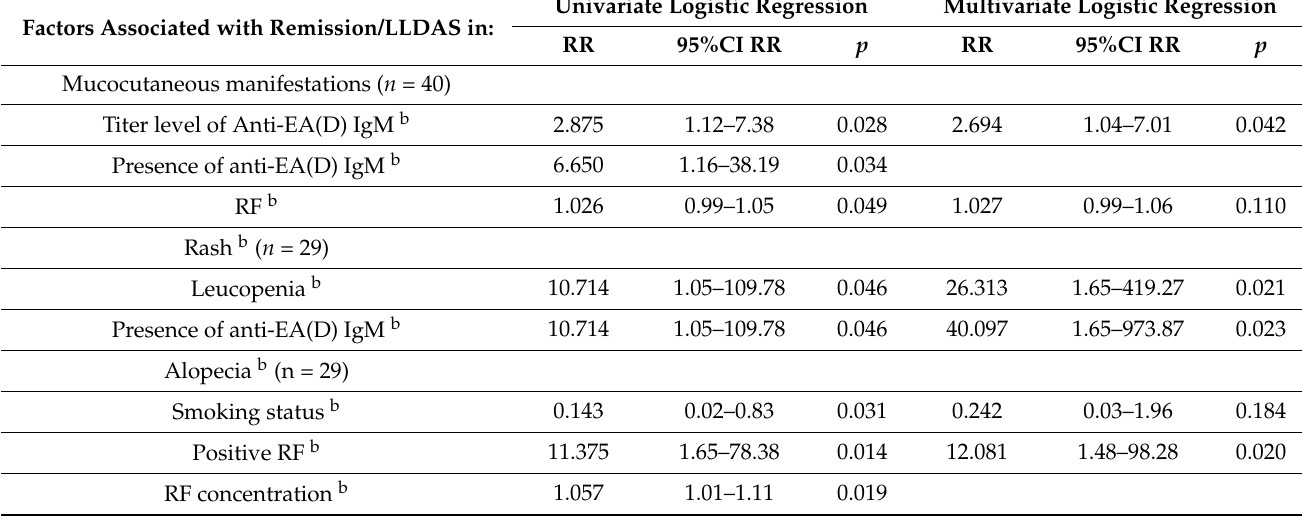
Table 4. Factors associated with remission and lupus low disease activity state (LLDAS) in SLE patients with active mucocutaneous manifestations at